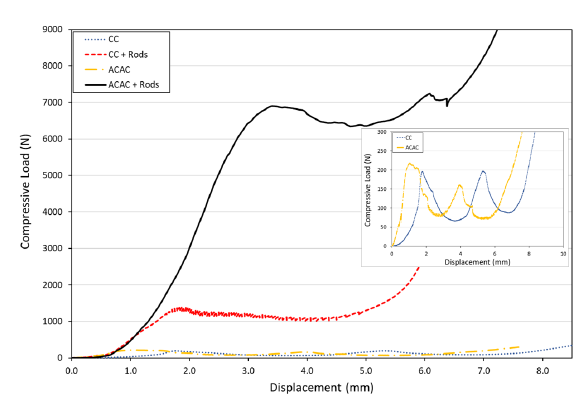
Figure 6: Load-displacement data of panels with two layers of card- board (CC) with and without rods, and two-layers of cardboard and two layers of aluminum in a aluminum-cardboard-aluminum- cardboard stacking structure (ACAC) with and without